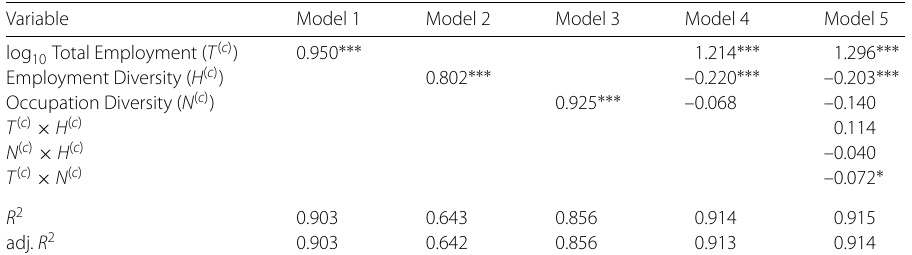
Table 2 Regressing urban labor statistics against log 10 the maximimum unemployment in each U.S. city during the Great Recession. All variables are centered and standardized prior to analysis. Model 1 Model